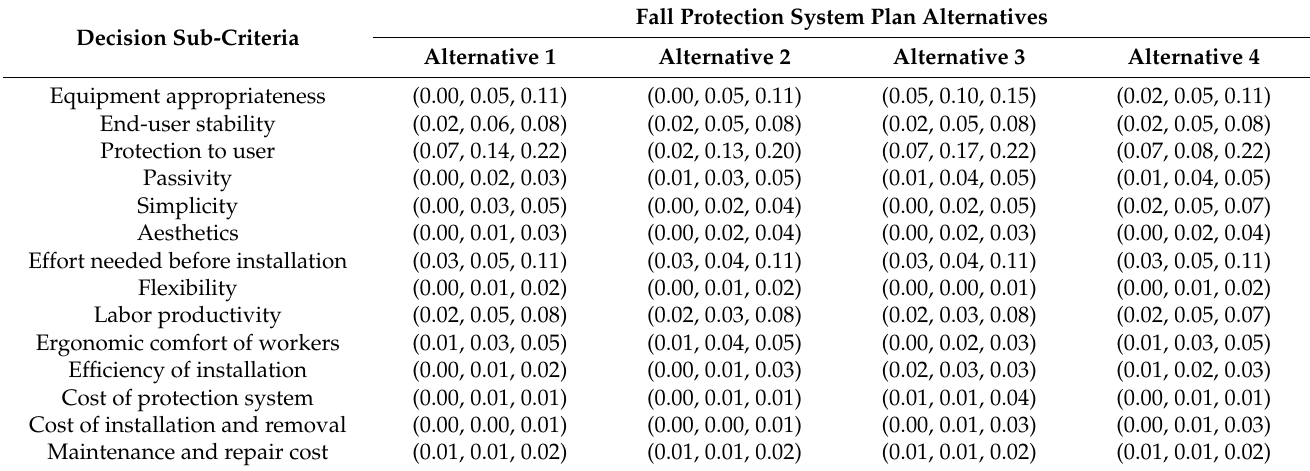
Table 8. Fuzzy-weighted normalized decision matrix for construction fall protection alternatives.